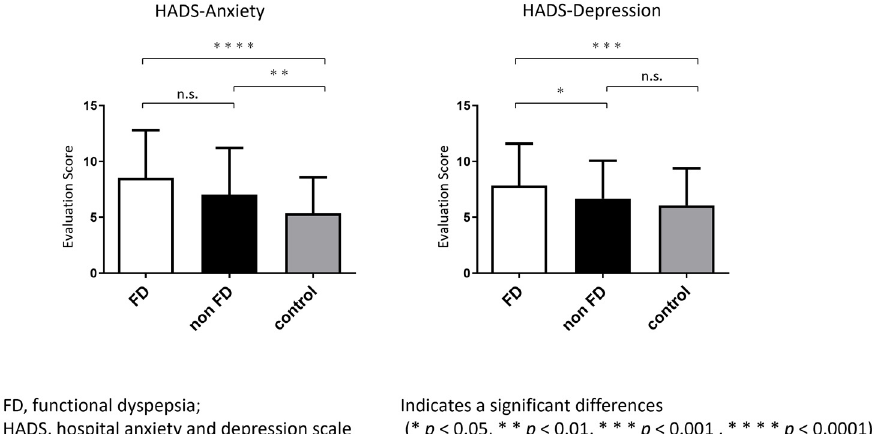
Figure A2. Psychological score of FD and non-FD patients.